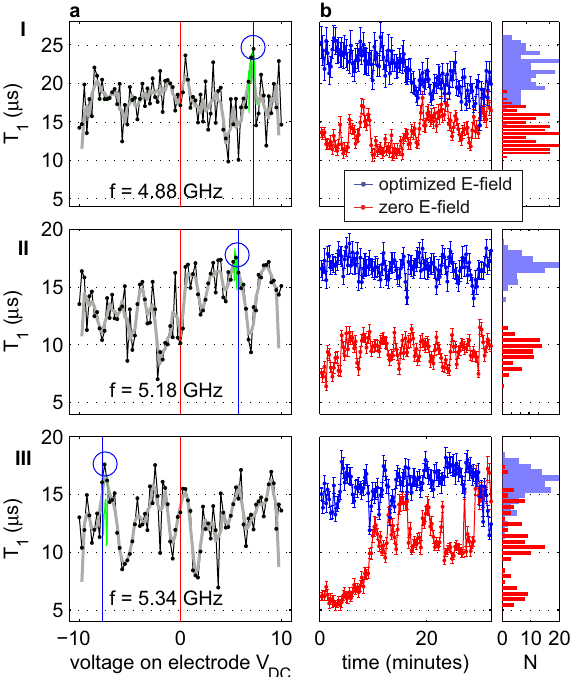
Fig. 3 Results. a Qubit T 1 times after E- fi eld optimization (blue data) and at zero applied E- fi eld (red data), tested at various qubit frequencies and averaged over 30 min. The error bars indicate the spread (standard deviation) of T 1 over 30 min. b Relative improve- ment of qubit T 1 after optimization. In a few cases, the routine results in a smaller T 1 time (red bars). Best and average T 1 -time improvements are 108 and 23.2%, respectively. c Fluctuations of T 1 - times (standard deviation over 30 min). On average, the fl uctuations were 17% higher for the optimized E- fi